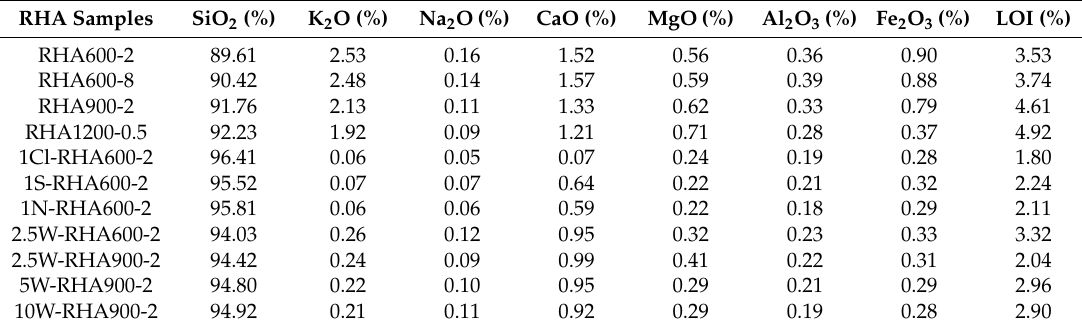
Table 1. Chemical composition of RHAs.